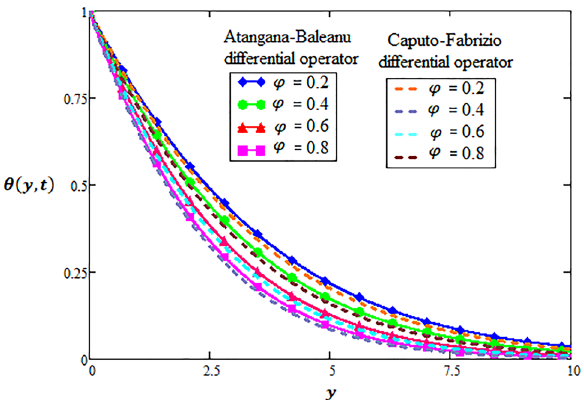
Figure 1. Variation of volume fraction for two-dimensional temperature distribution through AB-differential operator verses CF-differential